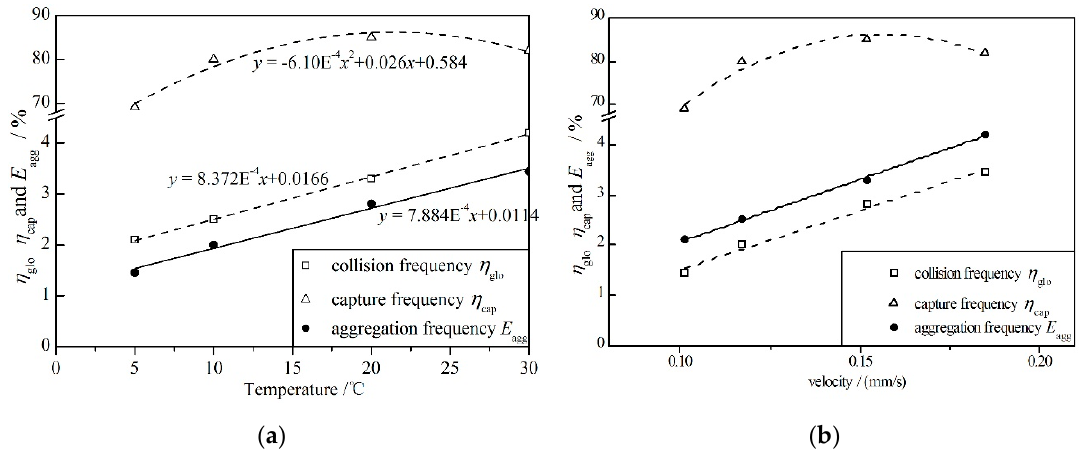
Figure 9. The change of Collision frequency η glo , capture frequency η cap and aggregation frequency E agg with ( a ) temperature and ( b ) settling velocity.